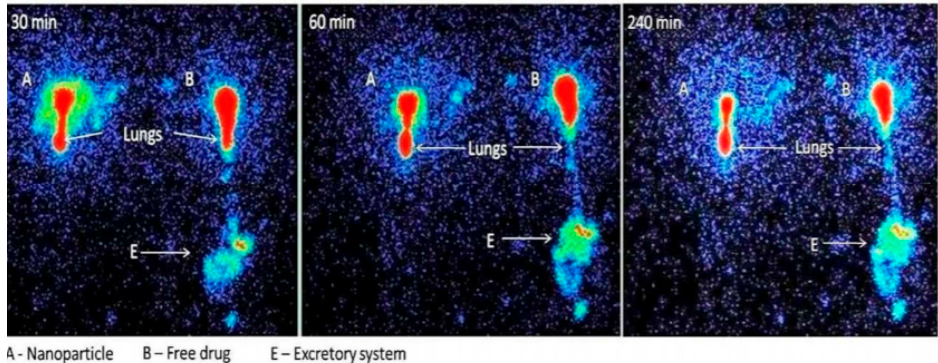
Figure 3. Gamma scintigraphy showing that 4 h post administration of free voriconazole accumulated in the excretory system whereas VNP remained in the lungs [64].